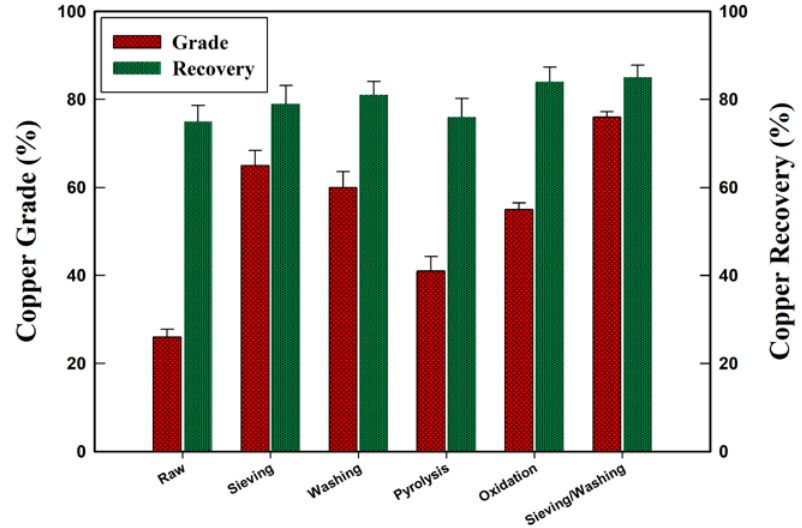
Figure 6. Comparison of electrostatic separation on ASR samples pretreated by sieving, washing, pyrolysis, oxidation and sieving/washing (an applied voltage of 30 kV, splitter position at 9 cm, relative humidity of 45%, and distance of 60 cm between the electrodes).